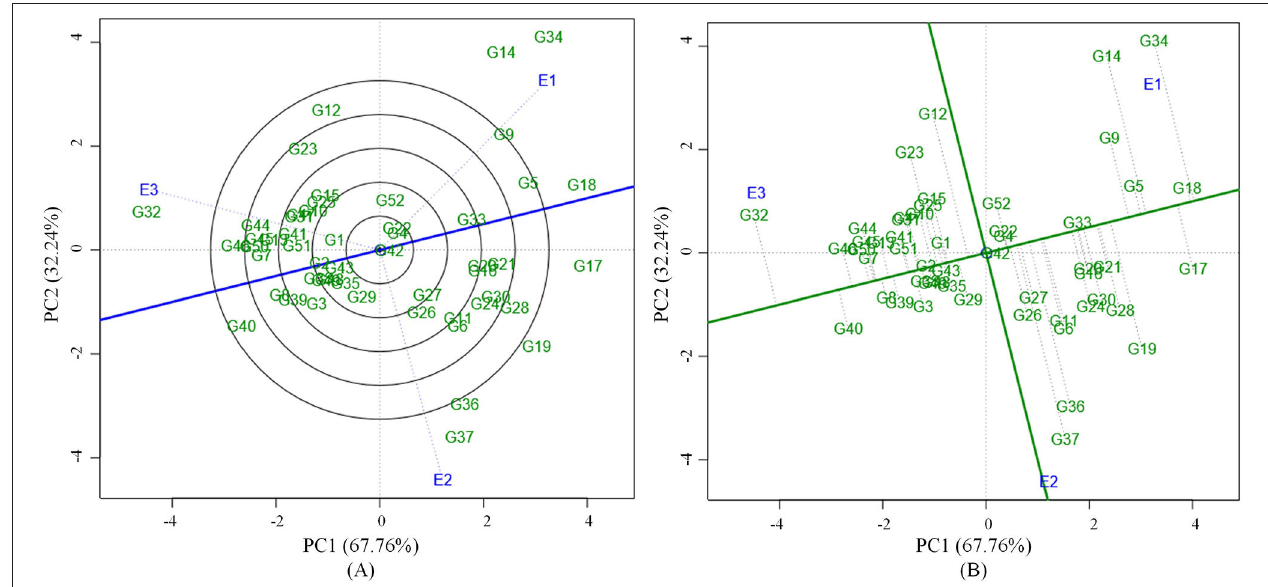
FIGURE 1 | (A) GGE biplot based on environment focused scaling for the comparison of three environments in relation to average environment axis (AEA) (blue line that passes through the biplot origin and the average environment). (B) Average Environment Coordination (AEC) view based on environment focused scaling for the pooled mean performance and the stability of 52 mungbean genotypes.